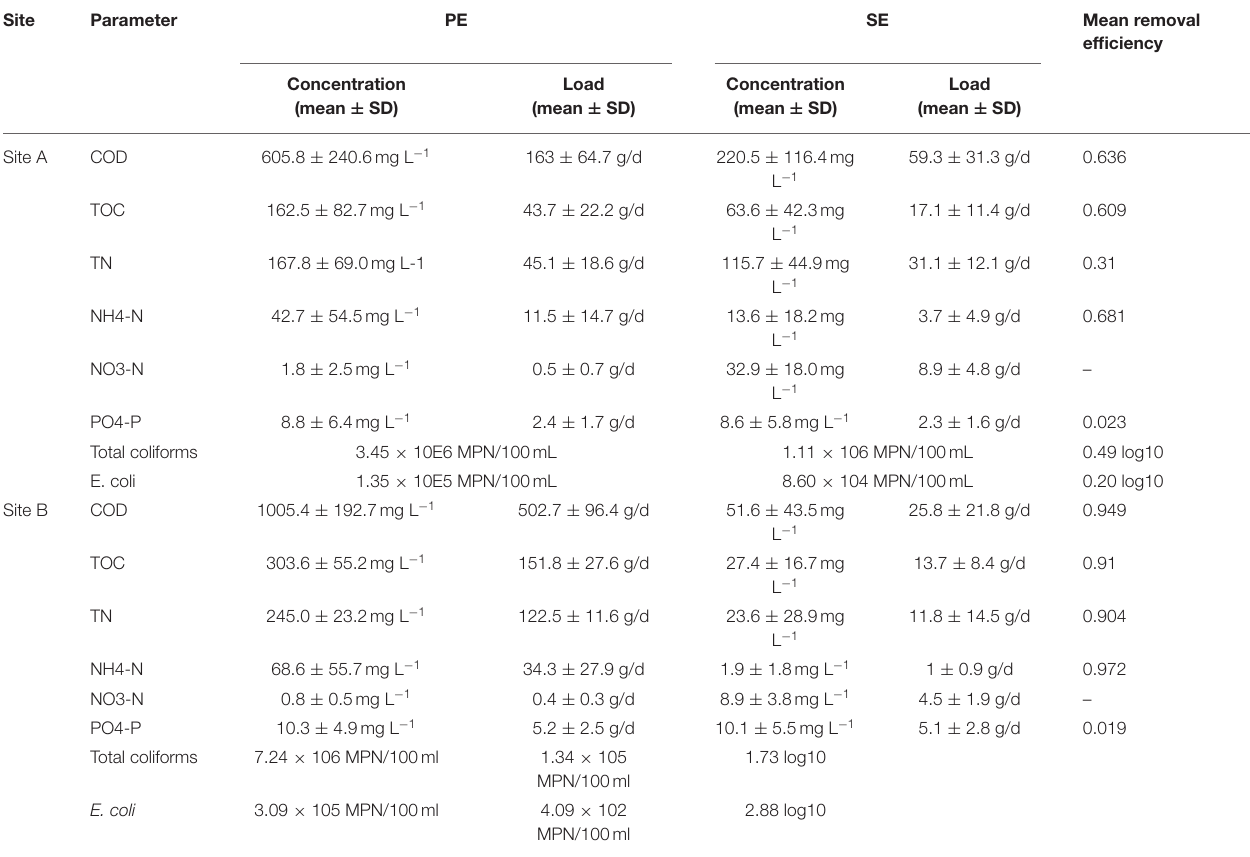
TABLE 3 | Effluent characteristics for the primary effluent (PE) from the septic tanks and secondary effluent (SE) from the packaged treatment units on Sites A and B over a 3-year period (from Knappe et al.,